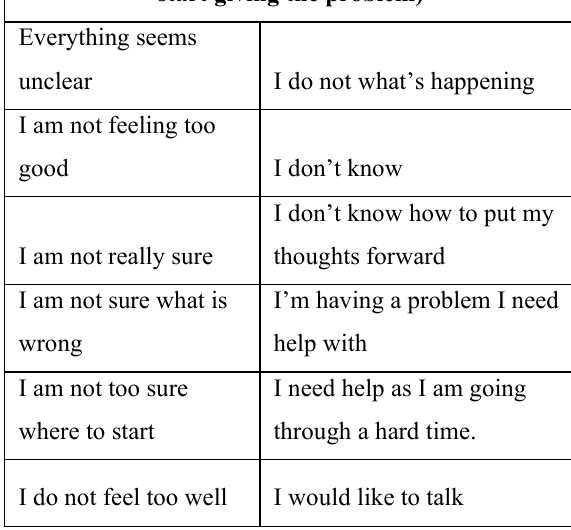
Table 4. Intent #Intro Details and case